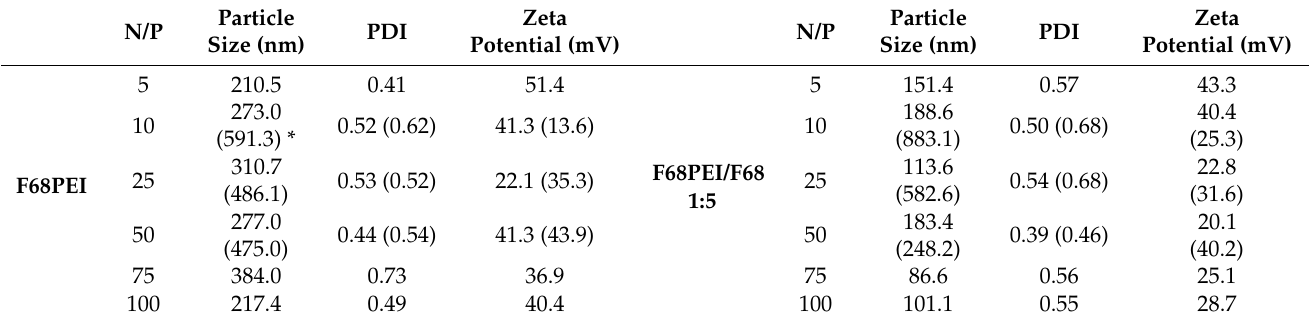
Table 1. Characterization of the polyplexes formed by F68PEI with pDNA (ddH 2 O, pH =